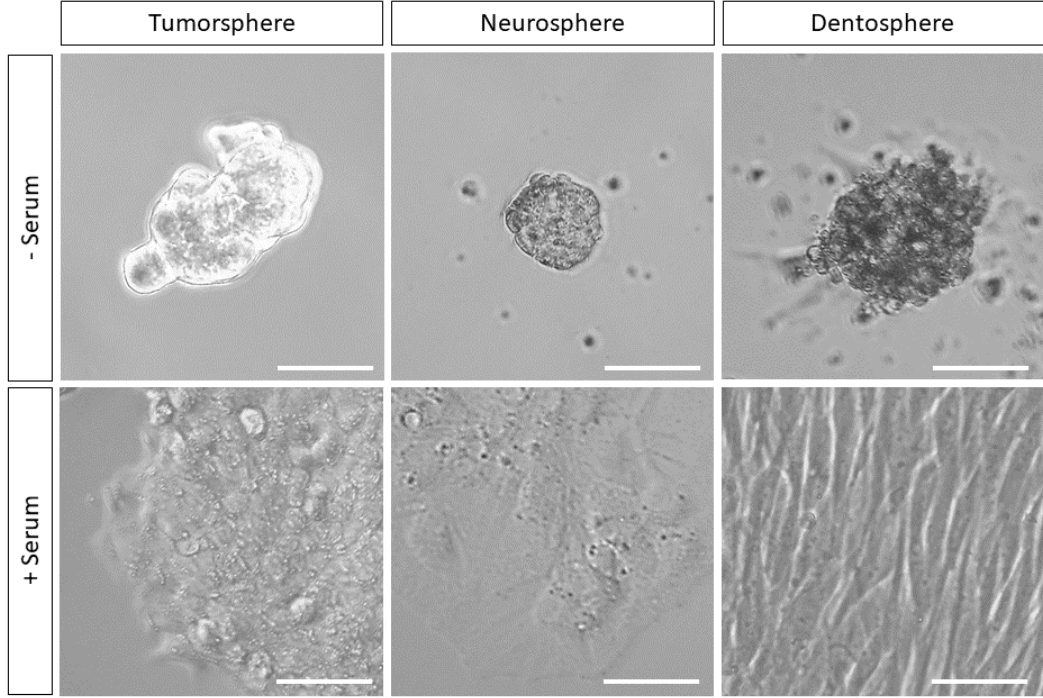
Figure 1. Stem cells and cancer stem cells (CSCs) from three different embryonic origins (endoderm, neuroectoderm, neural crest) can be maintained in the same cell culture media for long periods. Oncogenic CRC-derived SW620 colon cancer stem cells (CCSCs, left), and normal healthy neural stem cells (NSCs) (middle) and dental pulp stem cells (DPSCs) (right) can be grown under the same culture conditions in either the presence or absence of fetal serum. When grown on DMEM/F12 serum-free medium supplemented with basic fibroblast growth factor (bFGF) and epidermal growth factor (EGF), CCSCs, NSCs and DPSCs generate free-floating spheres (upper row) that can be in vitro maintained for several months. Cells from the same batches were grown in parallel with the same medium supplemented with 10% fetal bovine serum (bottom row), and in all these cases they generated plastic-adherent cell monolayers. Scale bars 50 μ m.